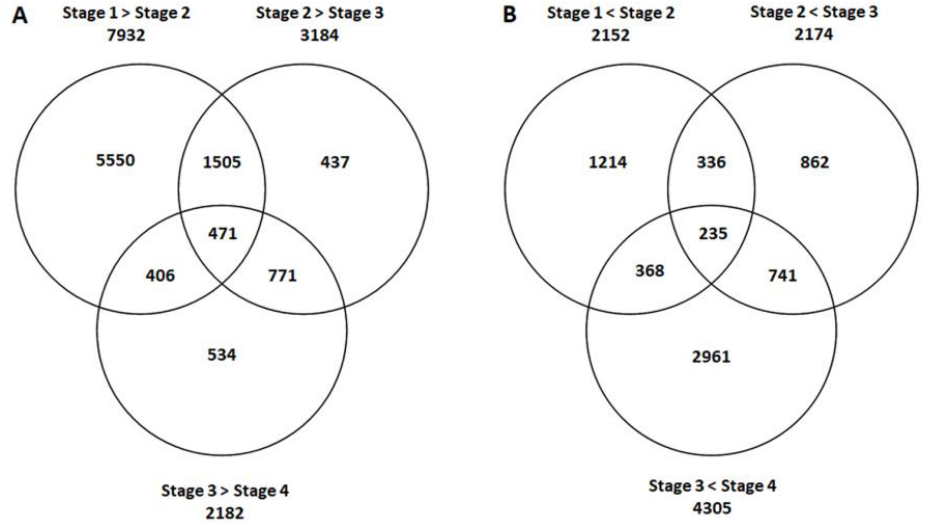
Figure 2. Summary of the number of genes significantly ( A ) down- or ( B ) up- regulated across stages of germination (Stage 1 → Stage 2: dormant conidia to polar growth; Stage 2 → Stage 3: polar growth to germinated conidia; and Stage 3 → Stage 4: germinated conidia to first branching). Based on their gene ontology (GO), 5313 of the genes that were well measured were attributed as components of biological processes, 2537 as cellular components, and 4633 as exhibiting molecular function. The majority of the genes expressed during germination were classified to transcription factor activity (411 genes), metabolic process (642 genes), and nucleic-acid binding (331 genes), all of which are apparently required for